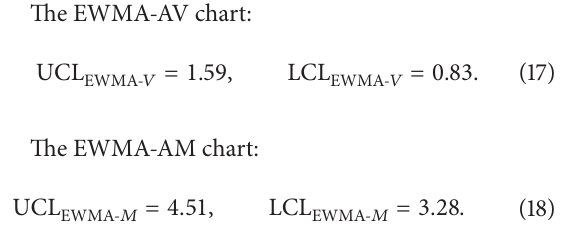
𝑉 /5)/15 = 0.24 ). The EWMA-AV and EWMA-AM (∑ 15 𝑡 𝑡=1 charts with 𝜆 1 = 𝜆 2 = 0.05 are constructed as follows based on the fifteen in-control samples,